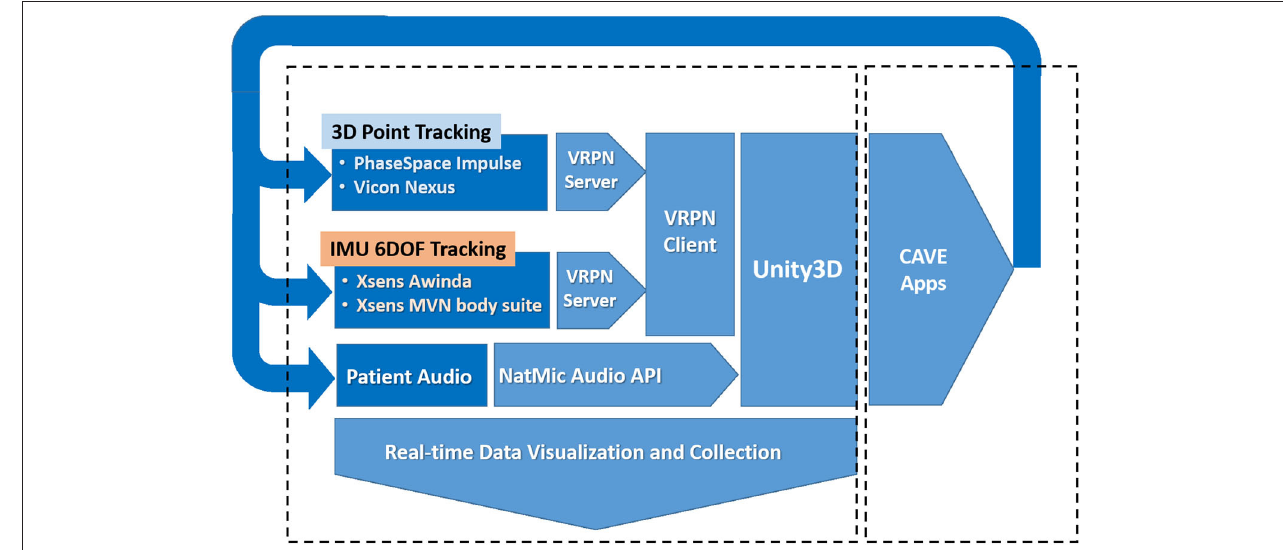
FIGURE 2 | Diagram of the system components.